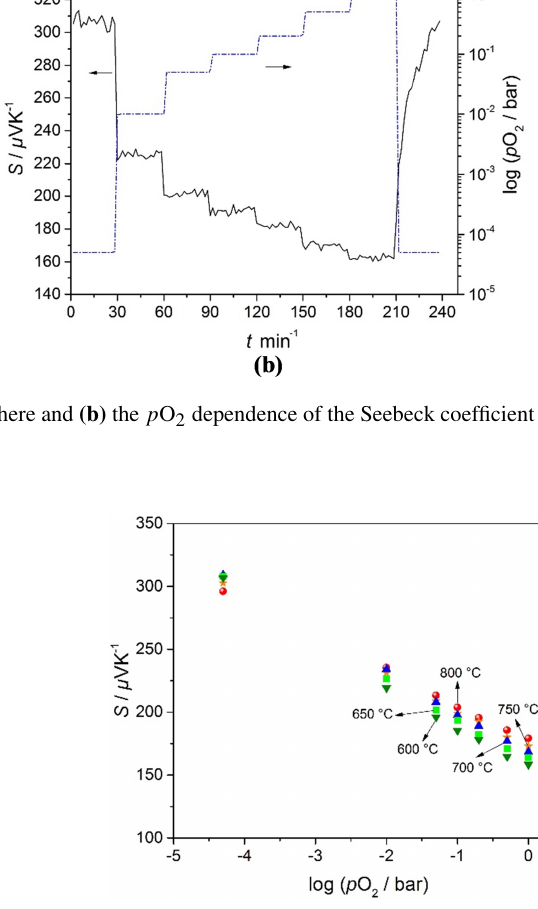
Figure 8. Seebeck coefficient vs. log p O 2 of BFAT30 AD thick film between 600 and 800 ◦